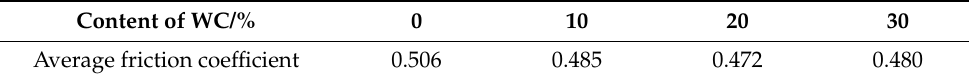
Table 5. Average friction coefficient of HEA cladding layers with different WC content.